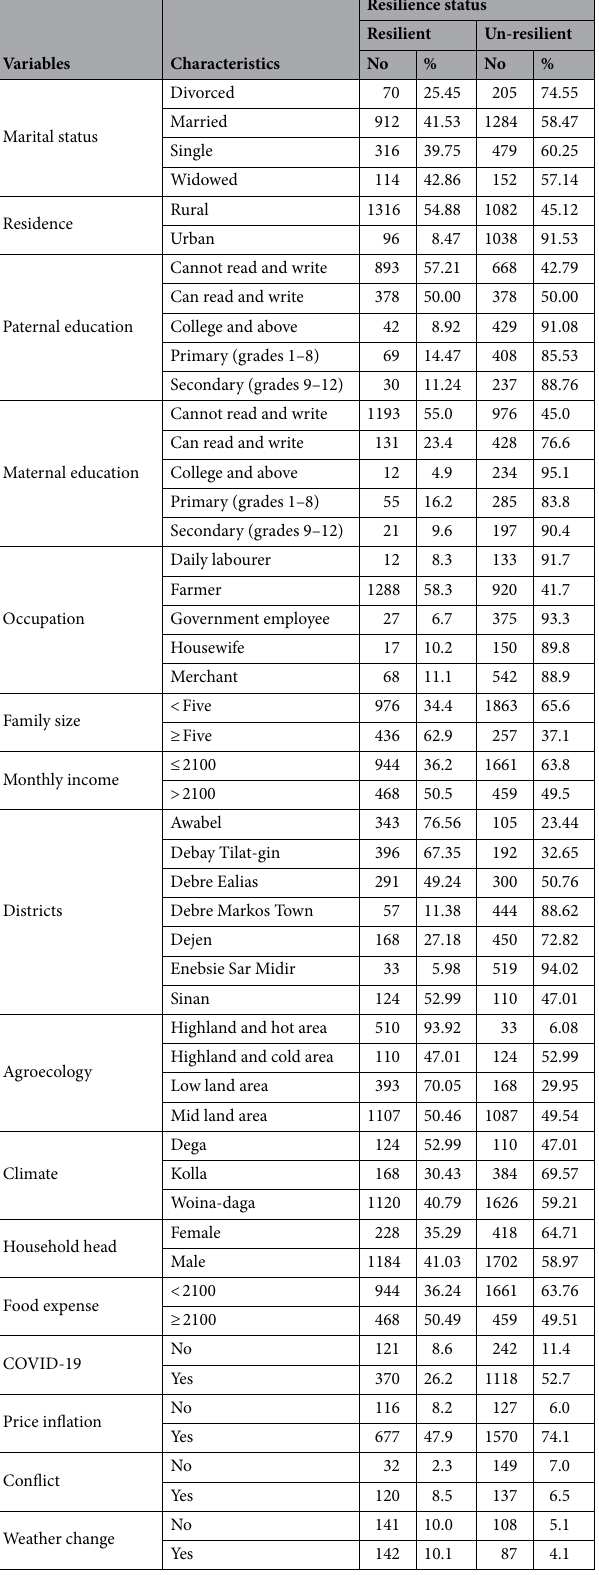
Table 4. Prevalence of non-resilience to food insecurity during at this time of COVID-19 pandemic and Public